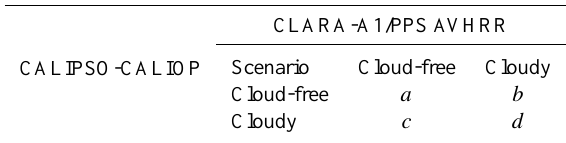
Table 1. Contingency matrix for the two different satellite observa-